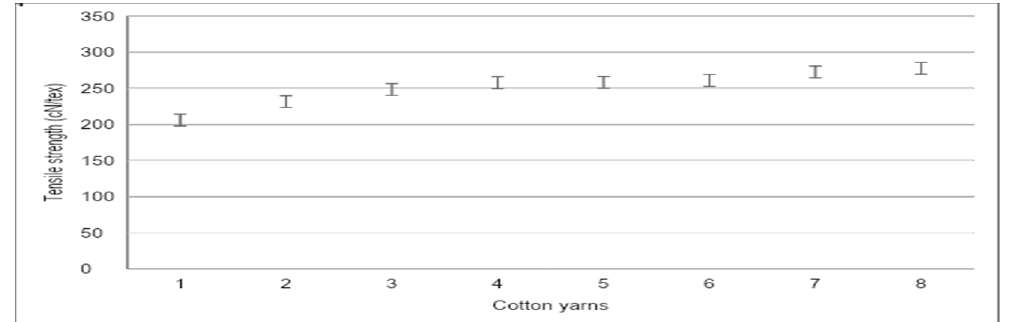
Fig. 1: Twist level and strength of yarns Table 2: Analysis of Variance Results of Yarn Strength